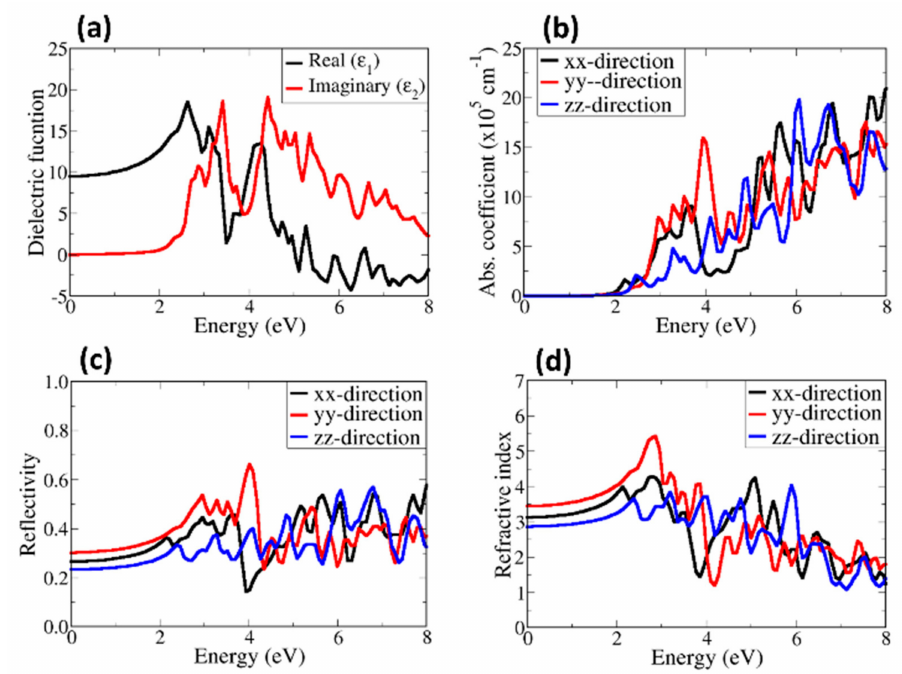
Figure 6. Calculated ( a ) dielectric function, ( b ) absorbance, ( c ) reflectivity and ( d ) refractive index of α –SrZrS 3